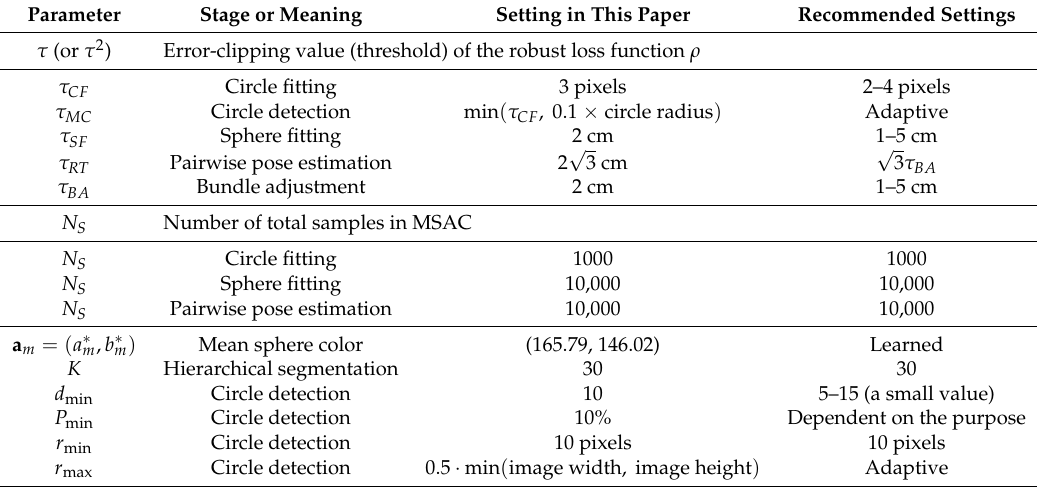
Table 1. Summary of the parameters used in this paper. The mean sphere color has been computed